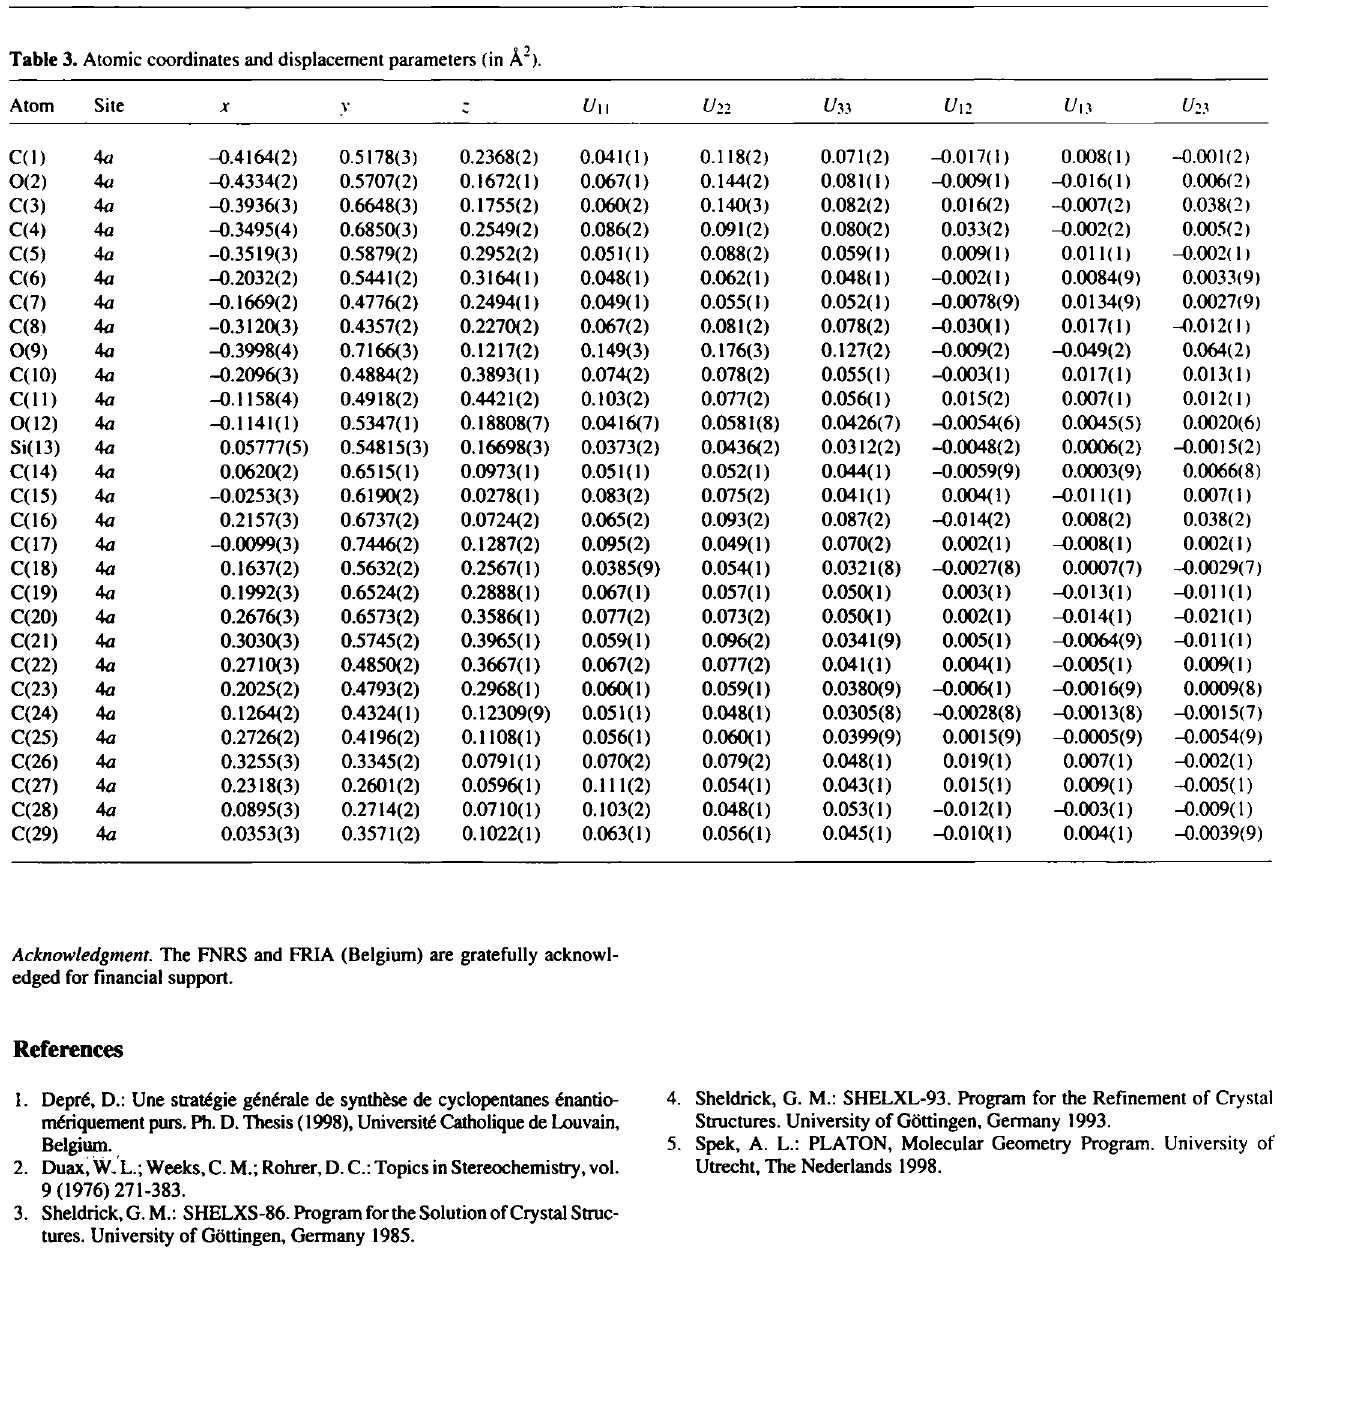
Table 3. Atomic coordinates and displacement parameters (in Ä 2